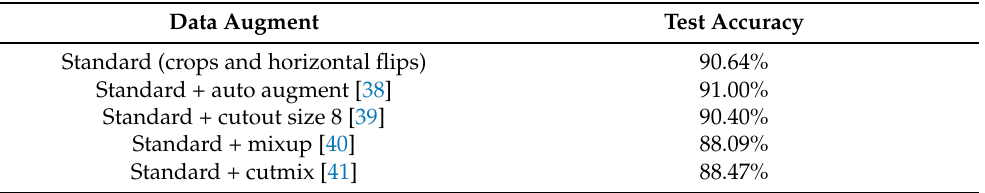
Table 2. Impact of the chosen data augmentation technique on the test sets accuracy when training augmented ThriftyNets with 40 k parameters and 20 iterations trained on